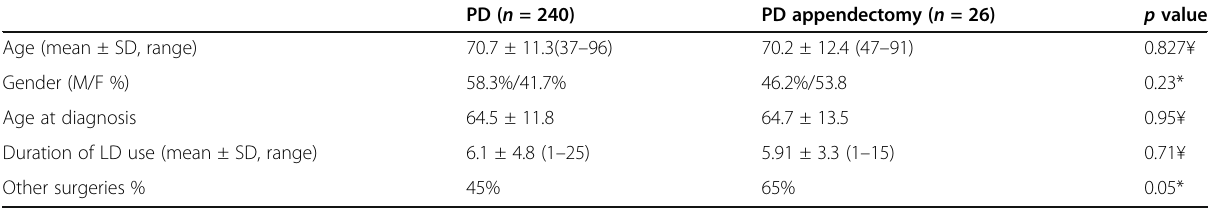
Table 2 Comparison between PD patients with appendectomy and those PD patients with no history of appendectomy PD ( n =